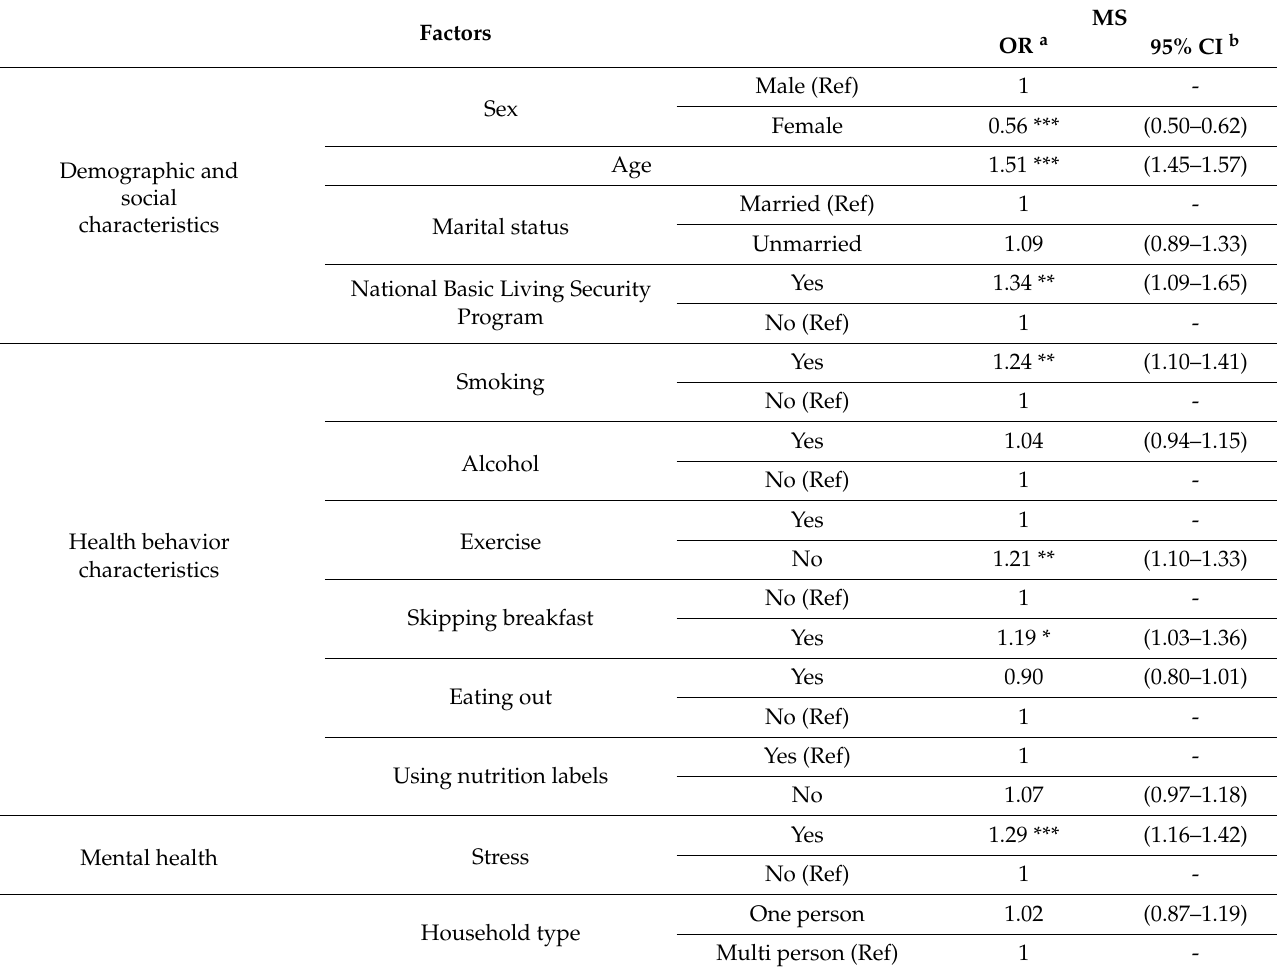
Table 3. Impact of the factor prevalence of metabolic syndrome using a complex survey